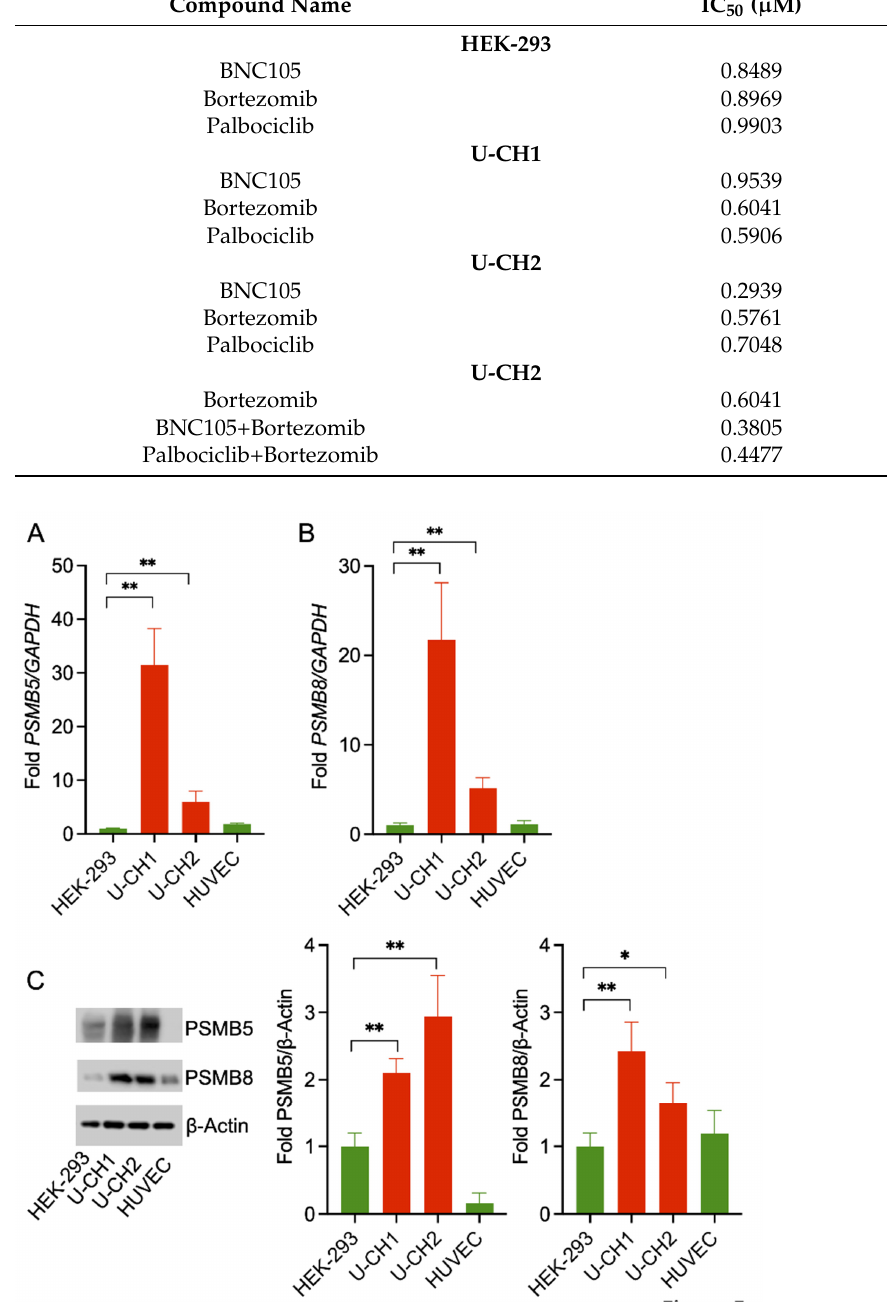
Figure 5. Proteasomal subunits PSMB5 and PSMB8 are increased in chordoma cells U-CH1 and U-CH2. Gene expression analysis by RT PCR represented as a fold change of ( A ) PSMB5 and ( B ) PSMB8, showing increased expression of PSMB5 and PSMB8 genes in U-CH1 and UCH1 cells as compared to HEK-293 and HUVEC cells. ** represents p < 0.01. ( C ) Western blo tt ing for PSMB5 and PSMB8 in HEK-293, U-CH1, U-CH2, and HUVEC cells showed increased protein expression of these two proteins in chordoma cells. β -Actin served as a loading control. Quantitation of PSMB5 and PSMB8 protein expression normalized to β -Actin. * and ** represents p ≤ 0.05 and p ≤ 0.01 respec- tively.